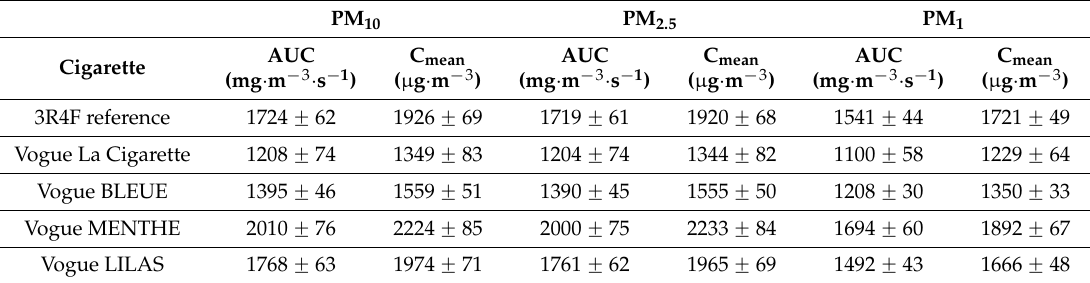
Table 2. Comparative table of particulate matter (PM) PM 10 , PM 2.5 , and PM 1 emissions in the